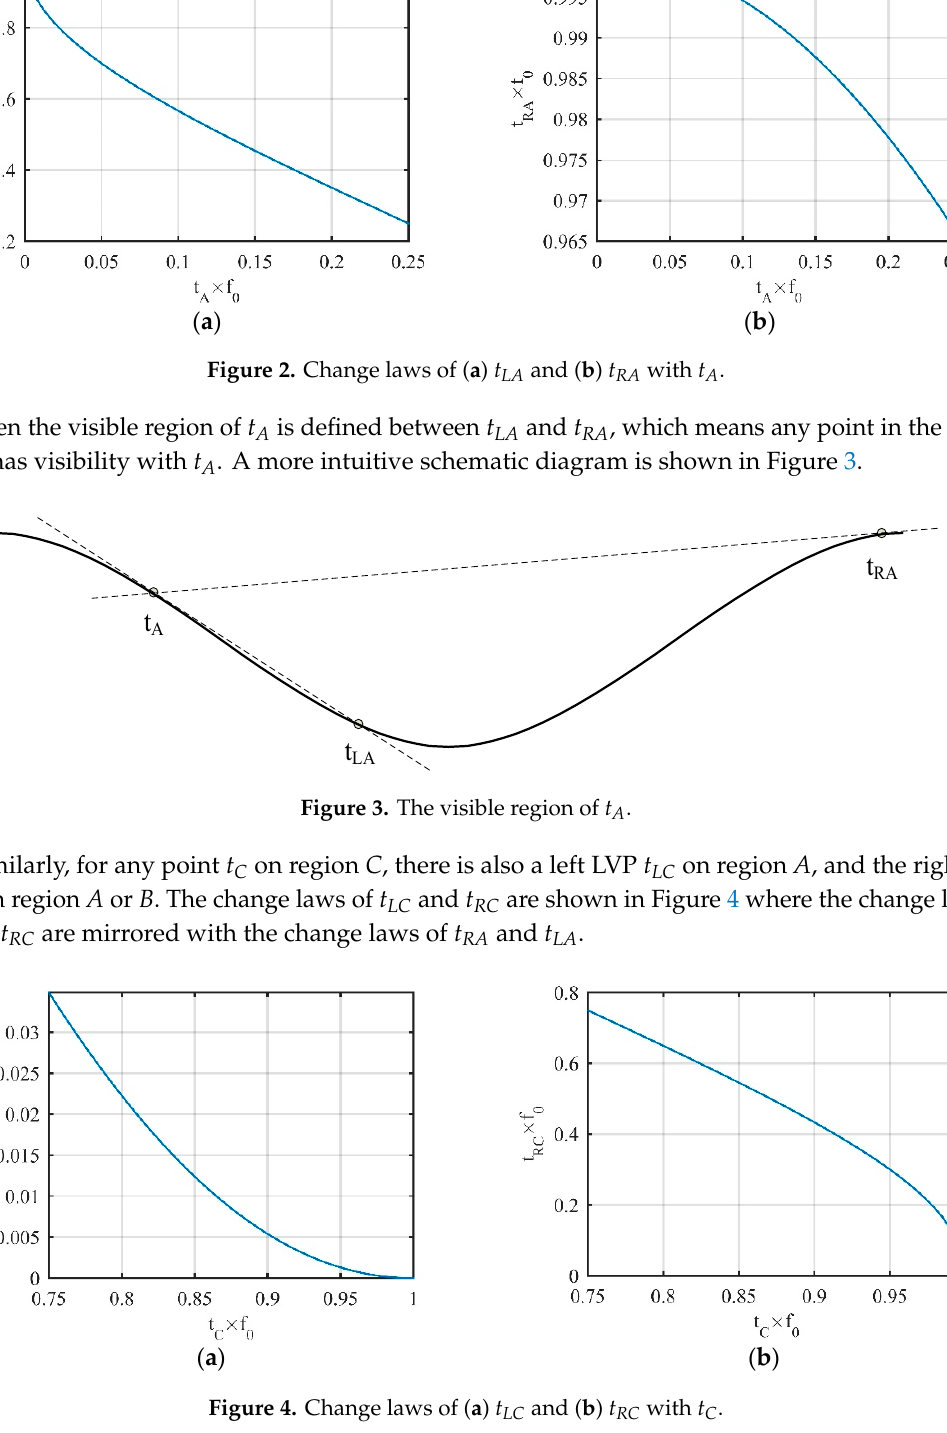
Figure 4. Change laws of ( a )